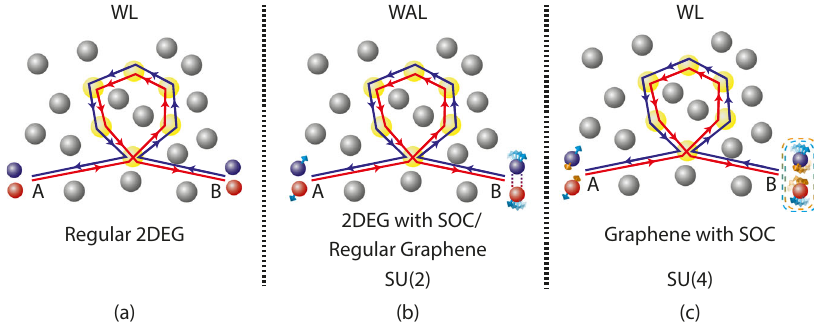
Fig. 1 Physical interpretation of quantum corrections to the electrical conductivity. Illustration of a self-intersecting path taken by an electron travelling from point A to point B. The red line indicates the path taken by the electron, whilst the blue line indicates the time-reversed path taken by the electron traversing the loop in the opposite direction to the red path. These are the paths that interfere and lead to quantum corrections. The red and blue spheres represent an electron and hole respectively, whilst the grey spheres denote background impurities in the material. The yellow spheres are the impurities involved in the scattering of the electron. a standard 2D electron gas (2DEG), where spin is irrelevant and we observe weak localisation (WL). b 2DEG with strong spin – orbit coupling (SOC) or ultra-clean graphene without SOC. The spin/pseudospin is represented by the arrow, and is scrambled upon traversing the loop. We observe weak anti-localisation (WAL) in this situation and fi nd that transport is governed by entangled states of spin/pseudospin. The SU(2) generators are used to model these systems. c ultra-clean Rashba-coupled graphene, where the electrons now possesses spin and pseudospin. Both spin- like quantities are scrambled by travelling along the loop, leading to a WL phase. The resulting transport modes are now entangled states of spin and pseudospin. The SU(4) generators govern the physics